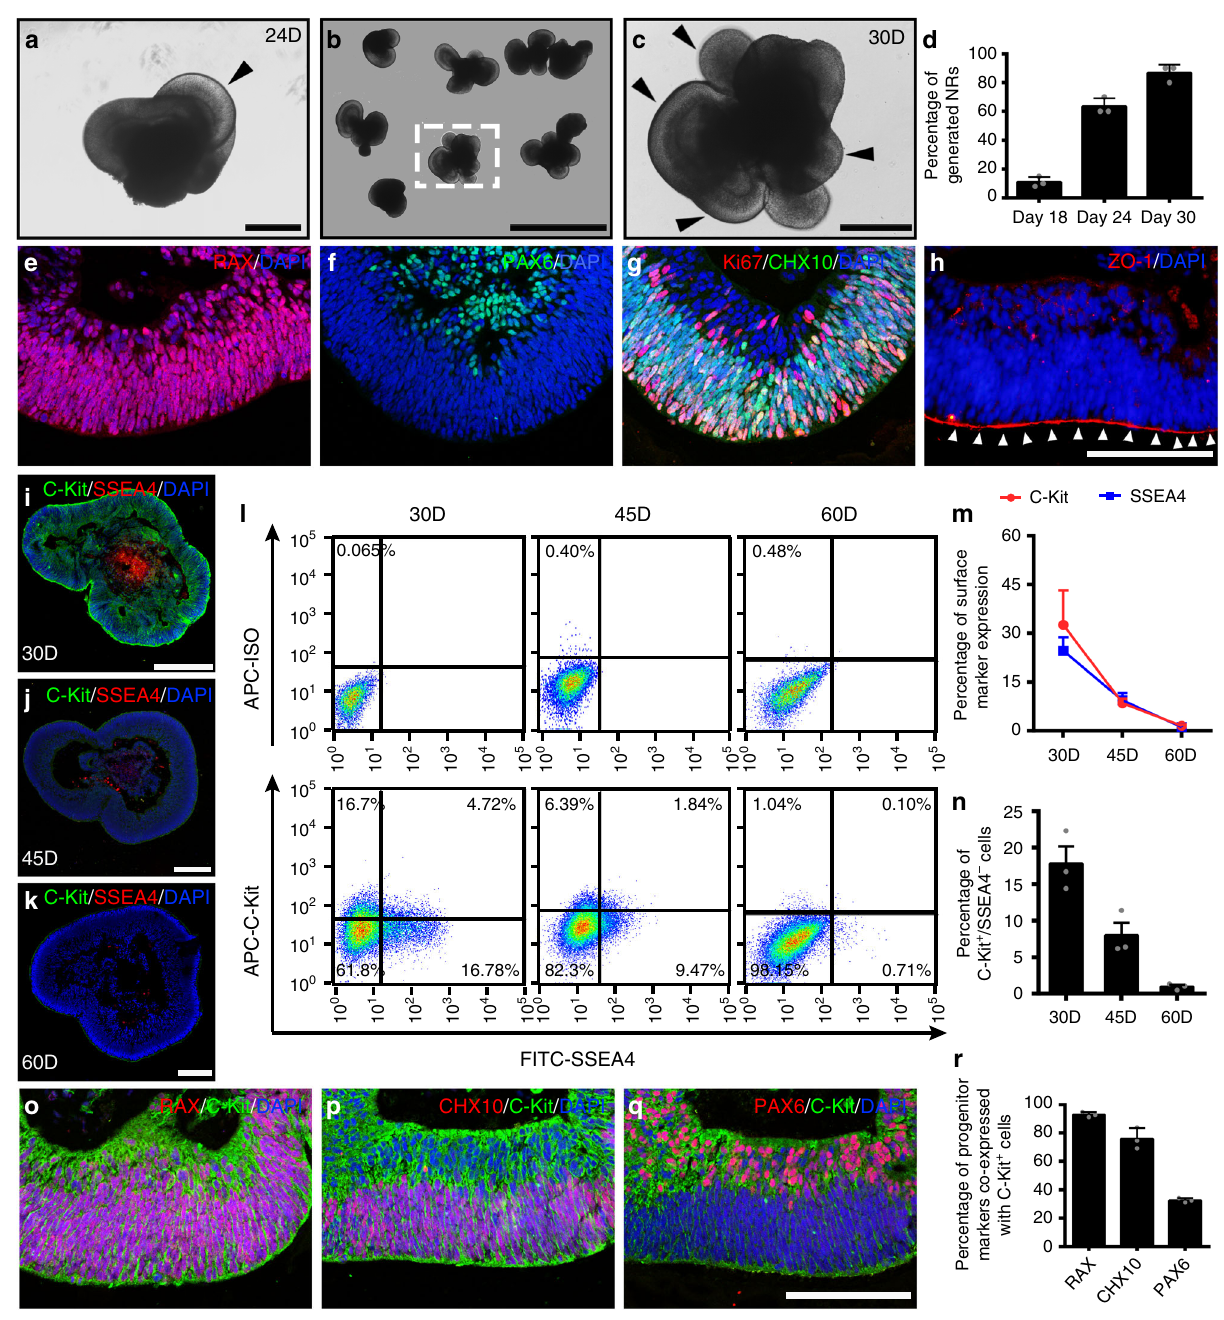
Fig. 1 Identi fi cation and C-Kit/SSEA4 expression in hEROs. a Induction of the 24-day neural retina structure (black arrowhead). b Induction of the 30-day neural retina. c Magni fi cation of the neural retina (black arrowheads) shown in b . d Quantitative analysis showing that the number of generated neural retinas increased with induction time (18-day: 11.1 ± 1.2%; 24-day: 63.3 ± 1.9%; 30-day: 86.7 ± 1.9%; n = 3 independent experiments/group; each experiment containing 96 hEROs.). e – g Expression of the RPC markers RAX, PAX6, and CHX10 and the proliferation marker Ki67 in hEROs. h Identi fi cation of the apical side of hEROs on day 30 via ZO-1 staining. i – k Distribution of C-Kit and SSEA4 antigens in 30-day, 45-day, and 60-day hEROs. l Flow cytometry analysis of C-Kit and SSEA4 expression in hEROs at different induction times (30-day, 45-day, and 60-day). m Statistical analysis of C-Kit and SSEA4 expression in hEROs (C-Kit: 30-day: 32.60 ± 10.58%; 45-day: 8.53 ± 1.36%; 60-day: 1.58 ± 0.45%; SSEA-4: 30-day: 24.6 ± 4.16%; 45-day: 9.35 ± 2.23%; 60-day: 1.17 ± 0.88%, n = 3 independent experiments/group; each experiment containing 192 hEROs). n Percentage of C-Kit + /SSEA4 − cells determined by fl ow cytometry analysis (30-day: 17.80 ± 4.06%; 45-day: 7.99 ± 2.96%; 60-day: 0.96 ± 0.42%; n = 3 independent experiments/group; each experiment containing 192 hEROs). o – q Co-expression of C-Kit and RPC markers in 30-day hEROs. r Quantitative analysis of RPC marker expression in C-Kit + /SSEA4 − cells in 30-day hEROs (RAX: 92.86 ± 1.88%; CHX10: 75.79 ± 7.46%; PAX6: 32.74 ± 1.58%; n = 3 independent experiments/group; each experiment containing 3 hEROs). Data are presented as mean ± SD. Scale bars, 200 μ m ( a , c , i – k ), 1 mm ( b ), 50 μ m ( e – h , o – q ). hEROs hESC-derived